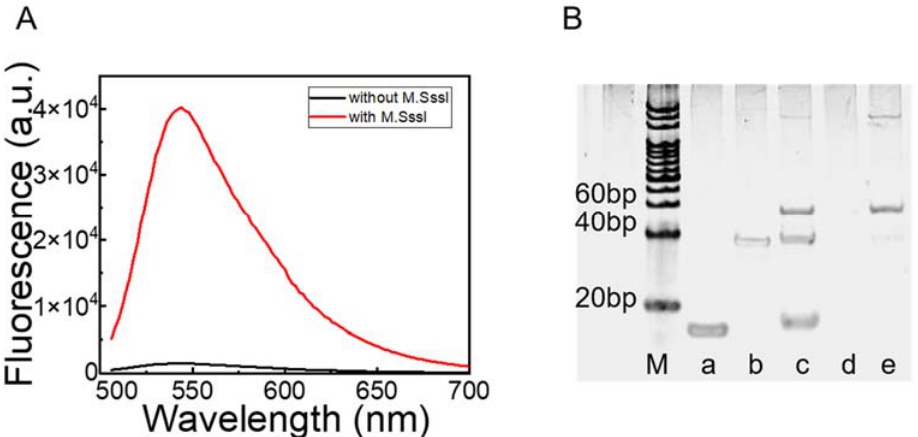
Figure 1. Feasibility of M.SssI detection with RCA. ( A ) Fluorescence emission spectra with or without M.SssI following the addition of SYBR TM Gold. ( B ) Polyacrylamide gel electrophoresis supports the feasibility of the strategy: (Lane M) 20 bp DNA marker; (Lane a) PPs; (Lane b) PPc; (Lane c) PPs + PPc + T4 DNA ligase; (Lane d) PPs + PPc + T4 DNA ligase + HpaII + lambda exo + ExoI; (Lane e) PPs + PPc + T4 DNA ligase + M.SssI + HpaII + lambda exo+